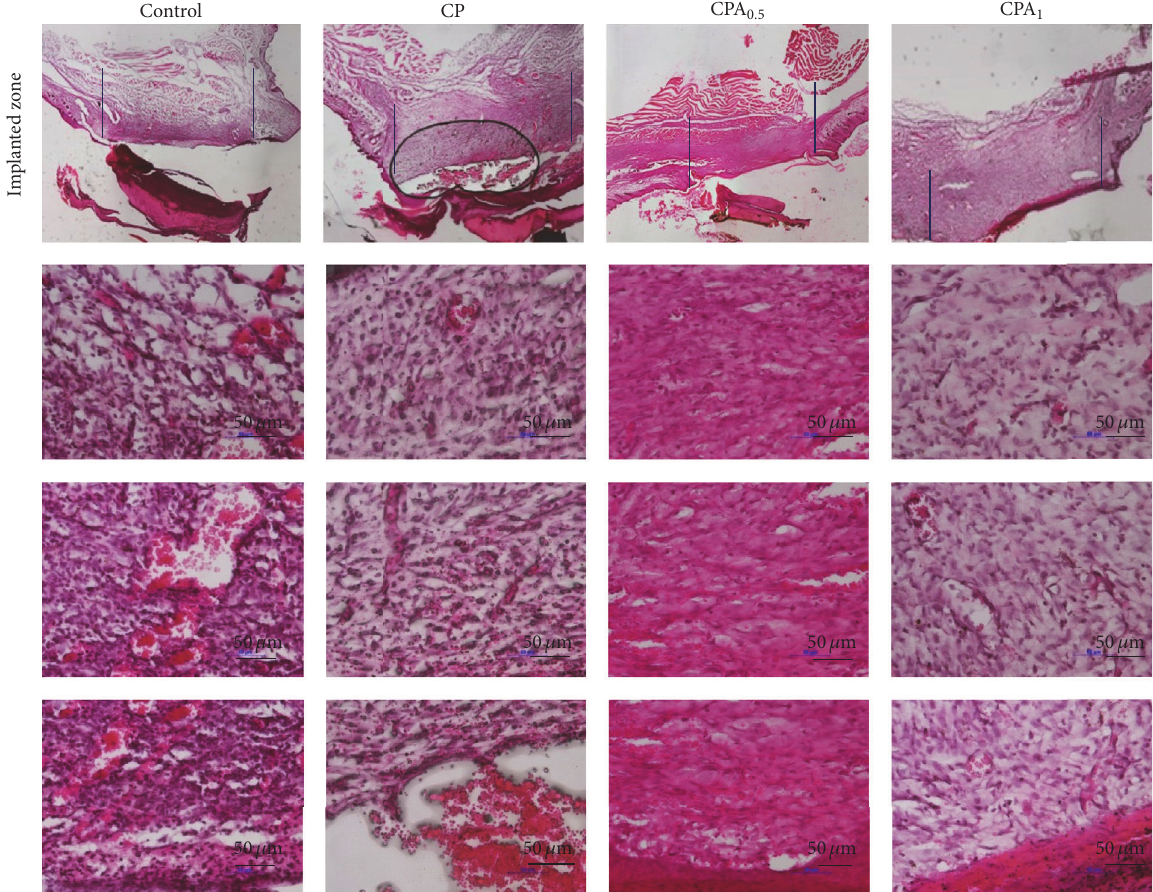
Figure 10: H&E staining images of untreated and treated with CP, CPA 0.5 , and CPA 1